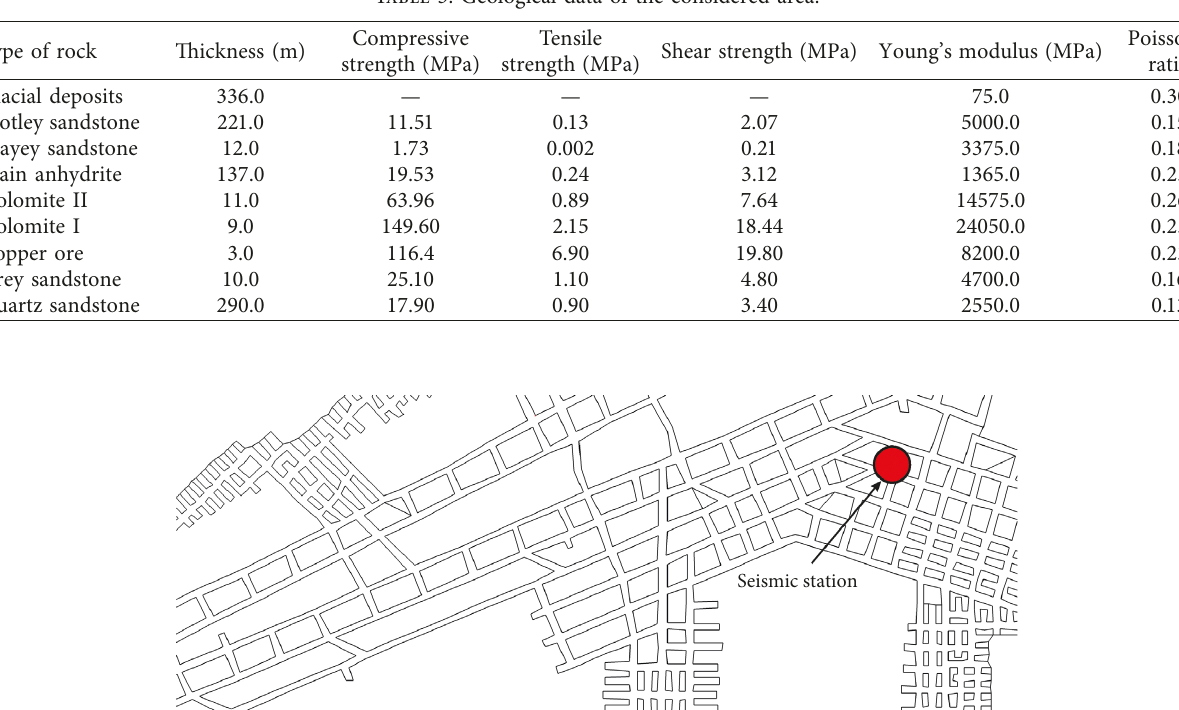
Table 3: Geological data of the considered area.